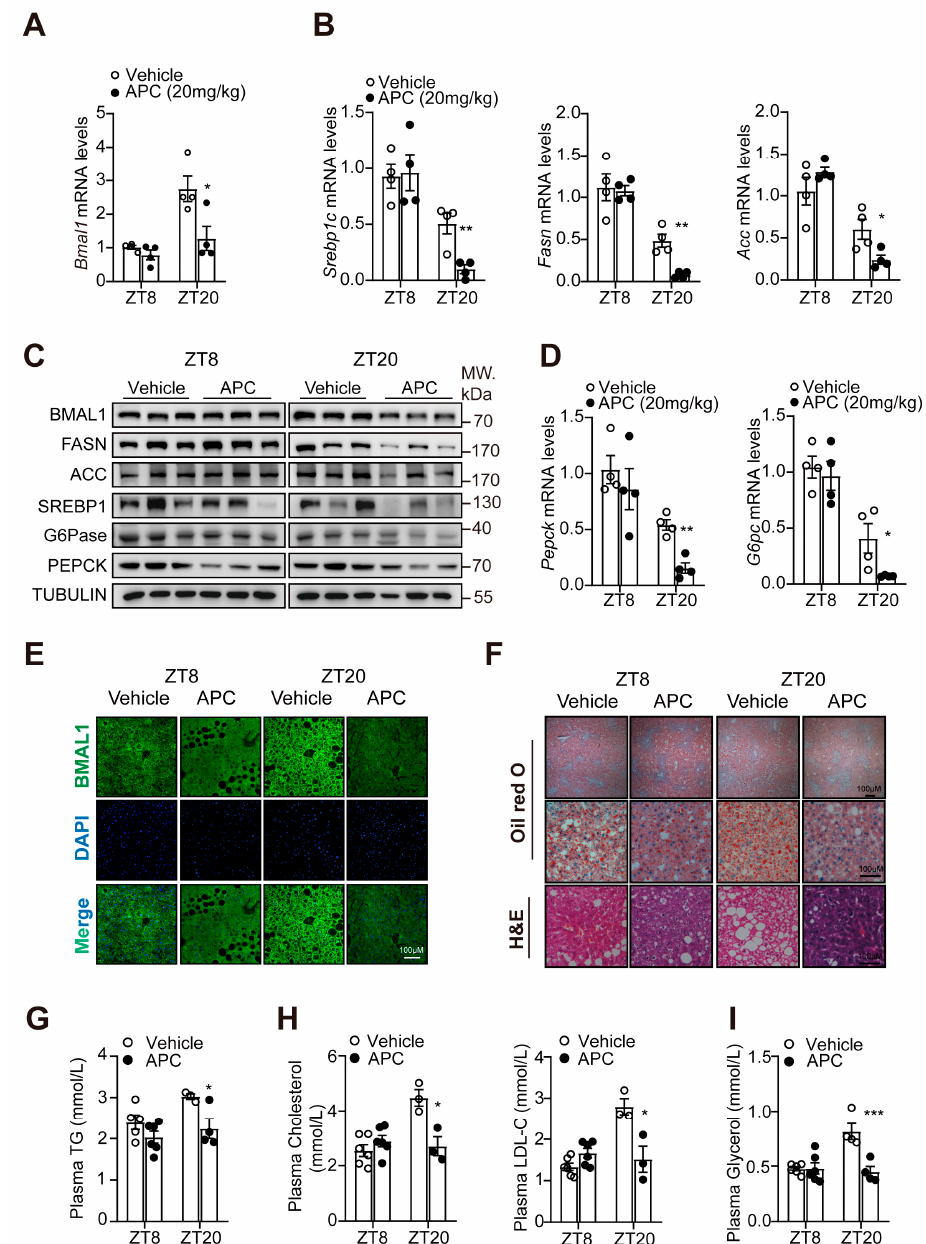
Figure 4. APC rhythmically inhibits hepatic glycolipid metabolism in db/db mice: ( A ) mRNA level of Bmal1 gene analyzed by real − time qPCR in livers; the db/db mice were treated by APC (20 mg/kg) or vehicle for 2 weeks ( n = 4 per group); ( B , D ) mRNA levels expression of Srebp1c , Fasn , Acc , G6pc , and Pepck gene analyzed by real − time qPCR in livers as treated in ( A ) ( n = 4 per group); ( C ) Western blots of BMAL1, PEPCK, G6pase, ACC, SREBP1, and FASN proteins in livers as treated in ( A ) ( n = 3 per group); ( E ) immunostaining of BMAL1 in the liver tissues of db/db mice; nuclei were stained with DAPI; the scale unit is bar, 100 µ M; ( F ) the liver tissues were isolated from db/db mice and Oil − red O and H&E staining were performed; the scale unit is bar, 100 µ M; ( G – I ) plasma TG, TC, LDL − C, and glycerol in the db/db mice at two different times at ZT8 and ZT20 ( n = 3 − 6 per group). * p <0.05; ** p < 0.01; *** p < 0.001.